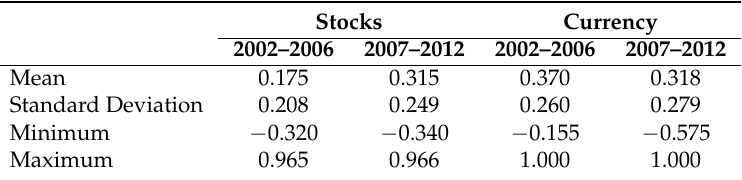
Table 1. Statistics for the pre-crisis and the crisis